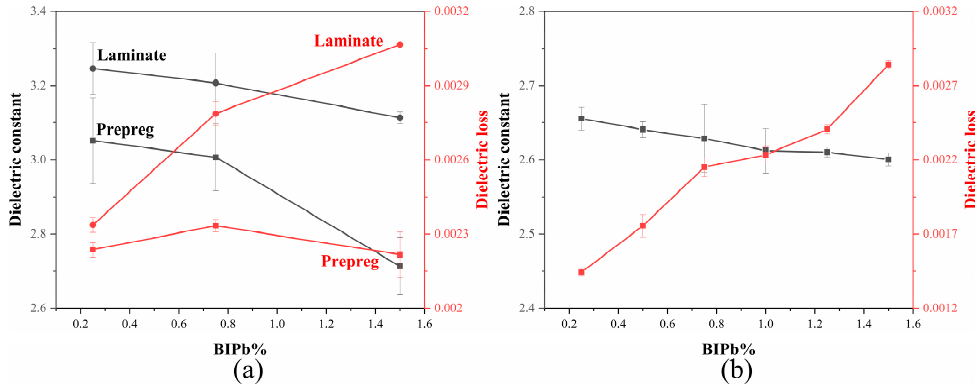
Figure 10. Dielectric properties of different initiator mass fractions: ( a ) laminate samples (the resin